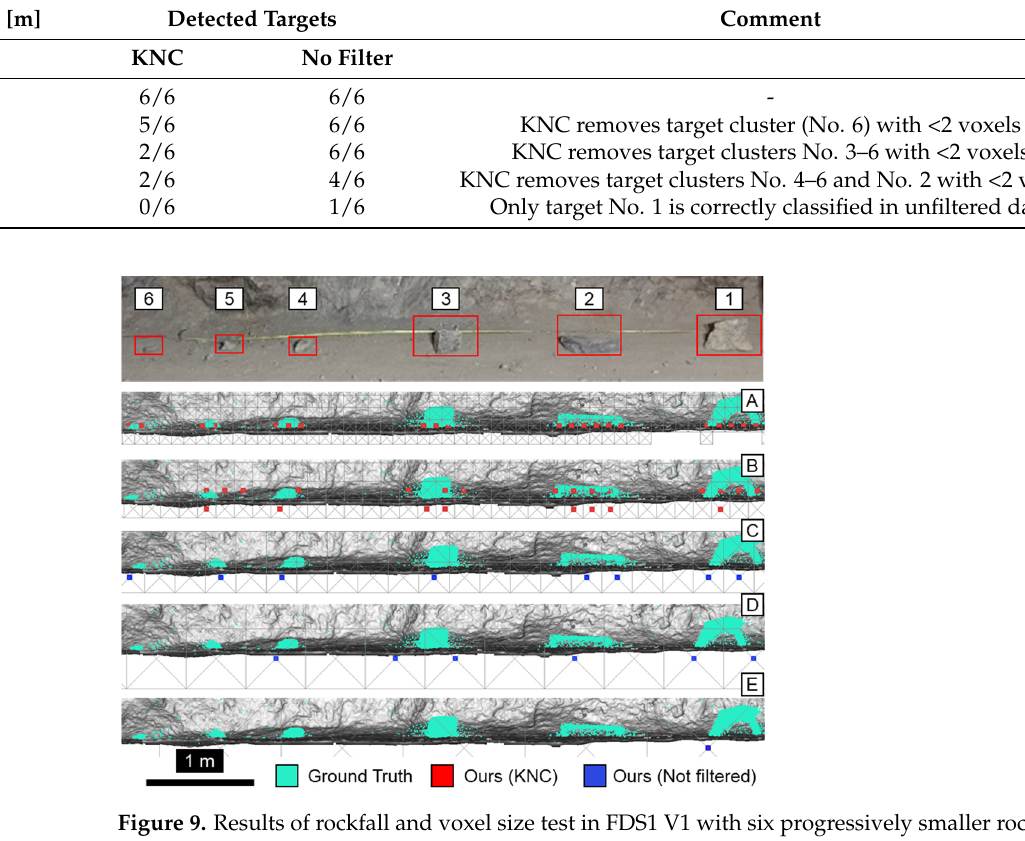
Table 3. Number of targets detected by M3C2 and our method.